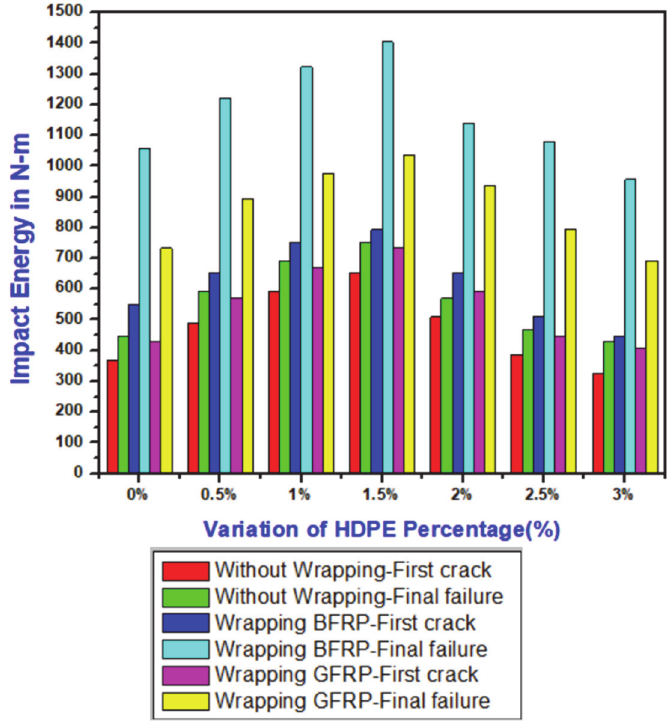
Figure 10: Variation Impact Energy vs wrapping of fibers and